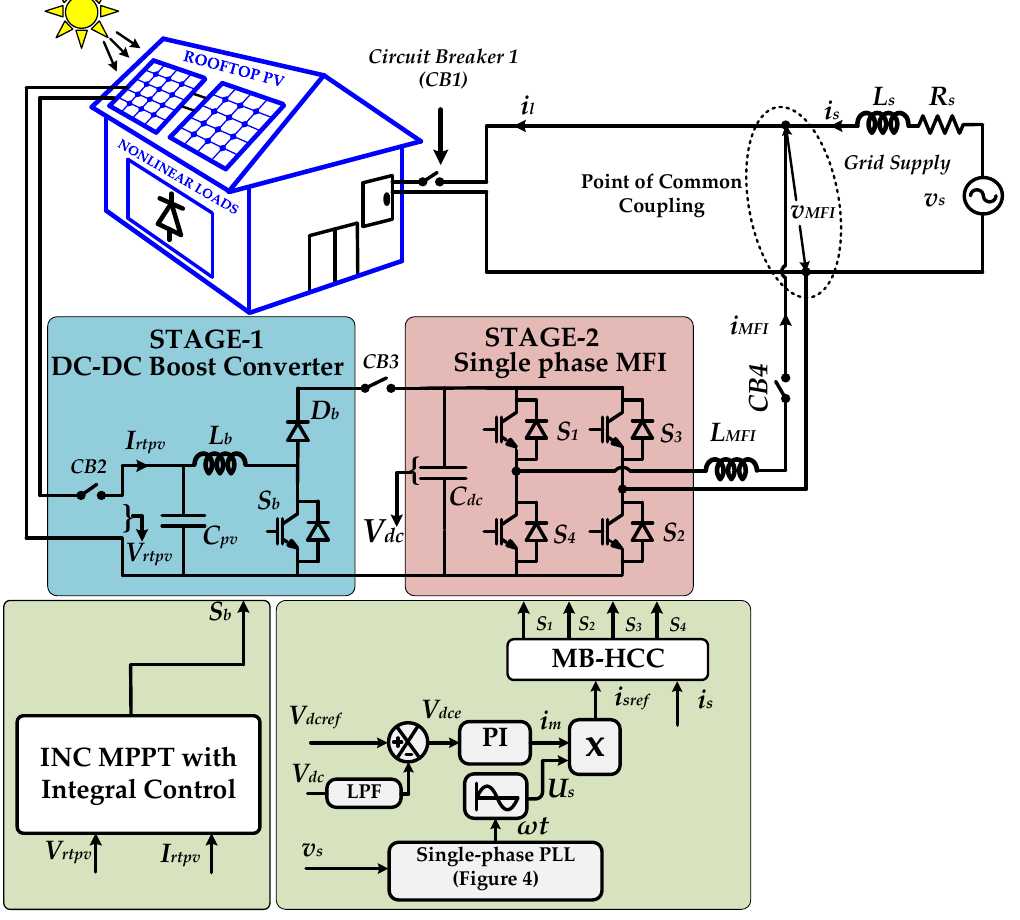
Figure 1. Proposed multi-band (MB)-HCC-based two-stage multi-functional inverter (MFI) for single-phase low voltage distribution systems (LVDS).